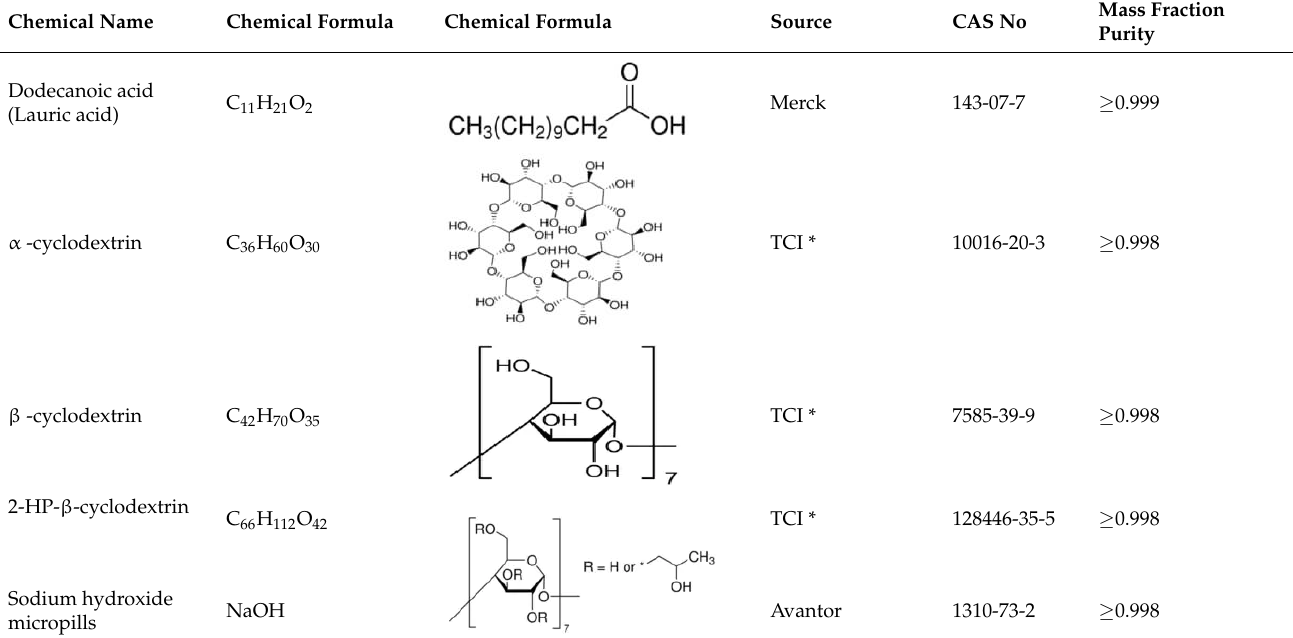
Table 4. Specification of chemical samples.